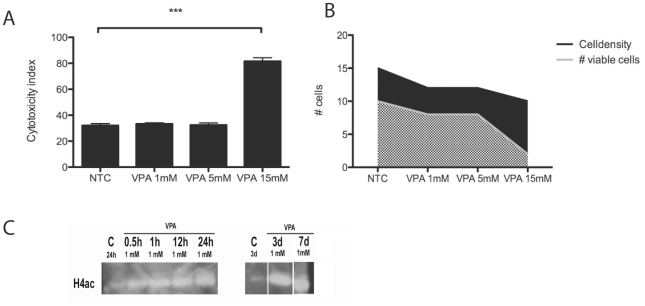
Cytotoxic effect of VPA on human pericytes.(A) Cytotoxicity index based on nuclear fragmentation and lysosomal pH in human pericytes exposed to 1–15 mM VPA for 3 days. (B) Cell density and viable cell measurement in human pericytes exposed to 1–15 mM VPA for 3 days. (C) VPA effects on histone 4 acetylation (H4ac) in human pericytes exposed for different time periods to 2 mM VPA. Mean ± standard deviation (SD), n = 4. T-test * p<0.05, ** p<0.01, *** p<0.001.